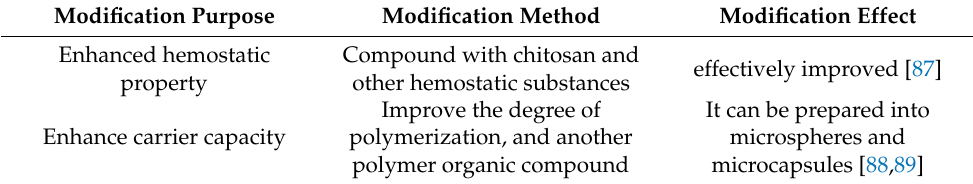
Table 4. Modification purpose, modification method, and modification effect of